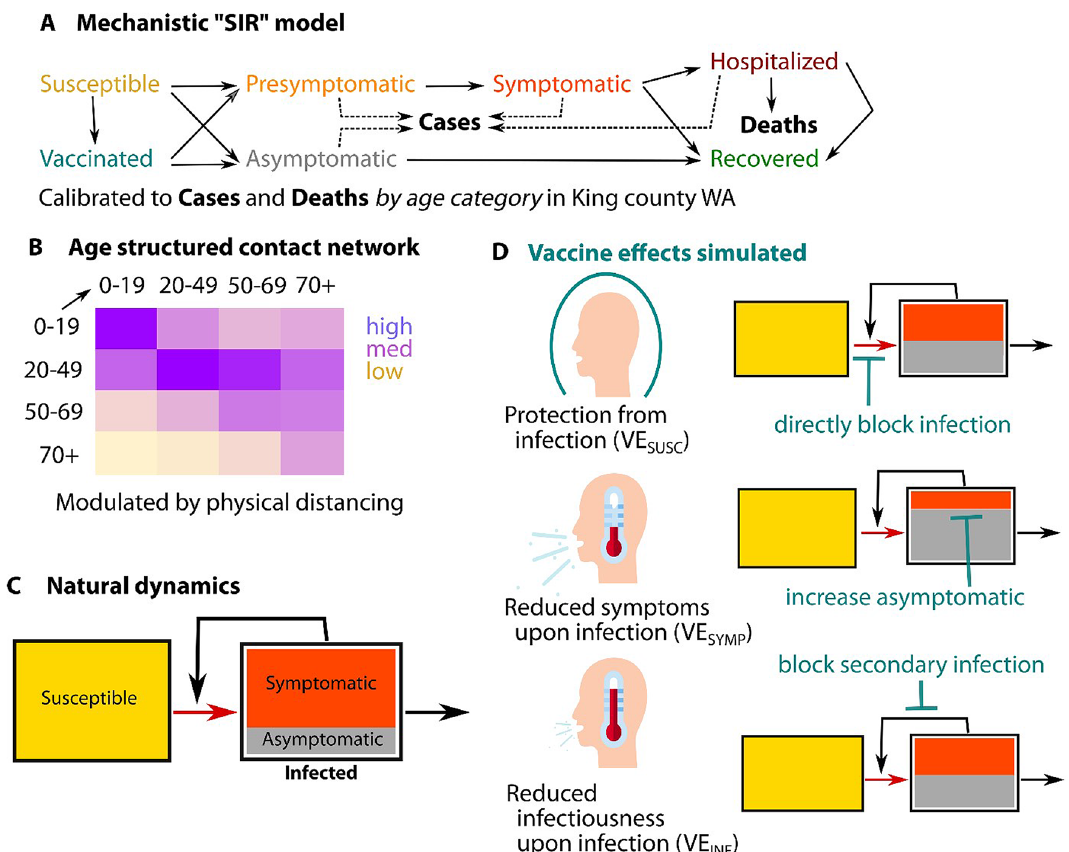
Figure 1. Schematic of the modeling analysis. ( A ) Diagram of the population transmission model with solid lines representing the flows of individuals between compartments and dotted lines indicating compartments which contribute to diagnosed cases; ( B ) mixing matrix between age groups showing proportions of contacts each group (row) has with the other groups (columns); ( C ) simplified diagram of the SARS-CoV2 transmission (red arrow) and the resulting force of infection (black arrow) in absence of vaccine and ( D ) the potential vaccine effects on the transmission and the force of infection.